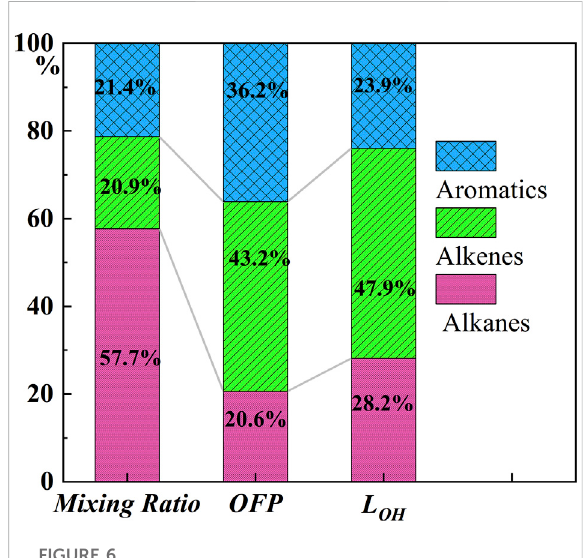
FIGURE 6 Relative contributions of mixing ratios, OFP, and LOH activities of alkanes, alkenes, and